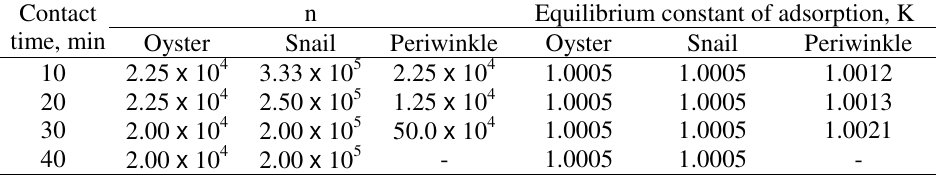
Figure 5. Curve fitting for adsorption of Pb ion on snail shell according to Freundlich isotherm. Table 2. Values of Freundlich parameters for adsorption of Pb 2+ on oyster, snail and periwinkle